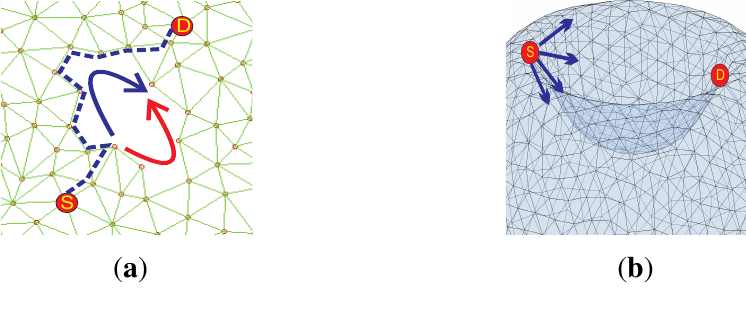
Figure 3. The storage load distribution in GDSTR-3D, where the storage load of a node is measured by the number of entries in its local convex hull